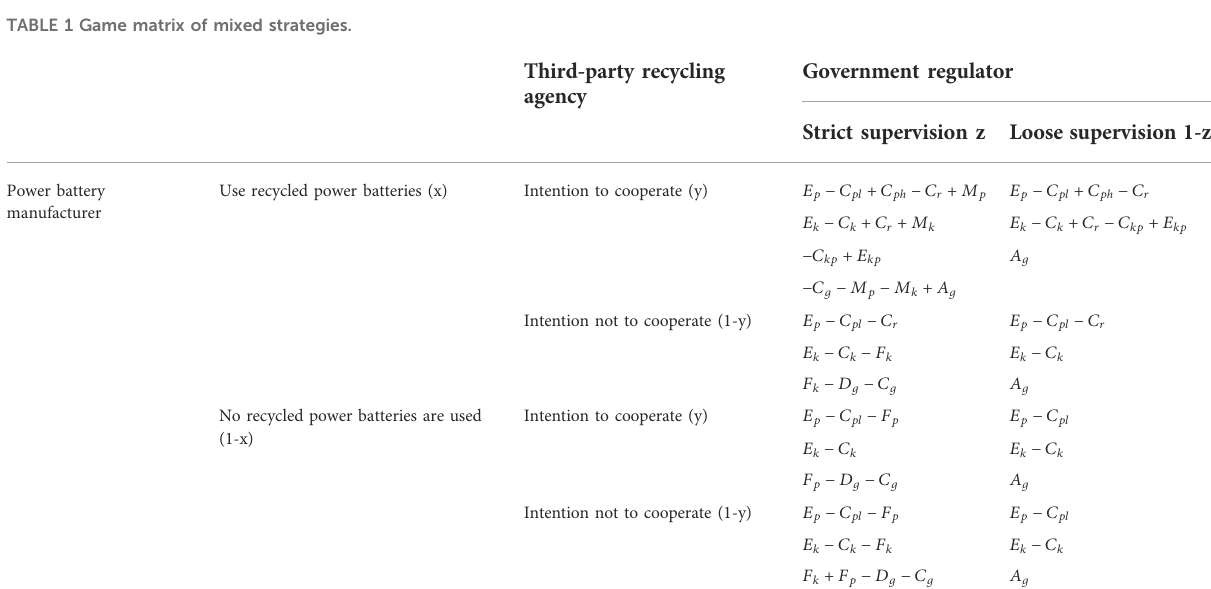
TABLE 1 Game matrix of mixed